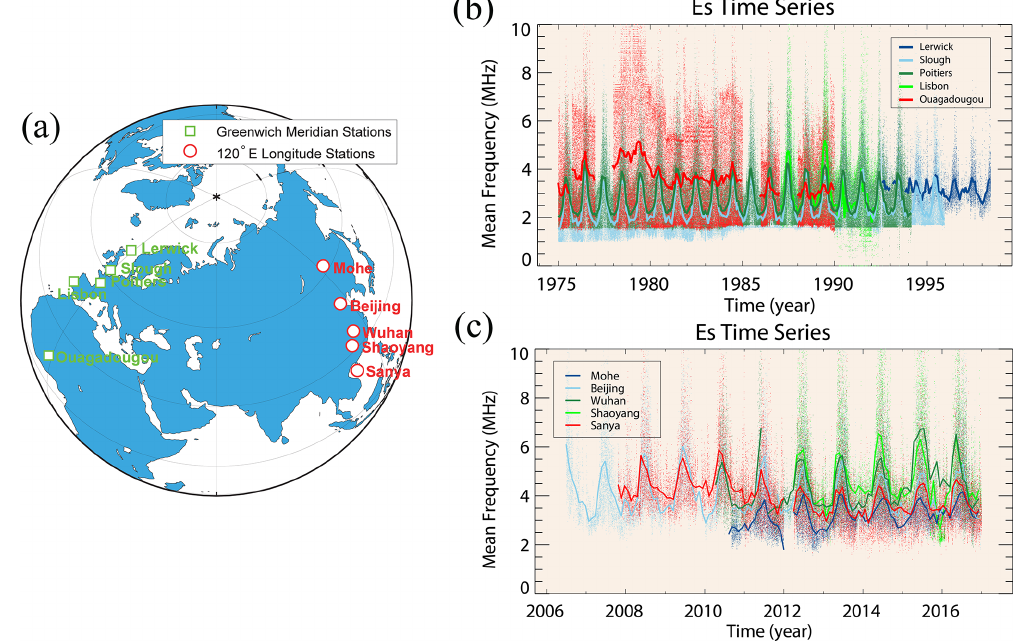
Figure 5. (a) Ground-based measurements of E s from two meridional chains of low-latitude to mid-latitude ionosondes. There are 10 ionosonde stations in these two meridional chains, roughly along the Greenwich meridian (b) and 120 ◦ E (c) . These ionospheric observations started in 1975. A 35-year dataset is analysed to try to identify the signature of the large-scale horizontal transport of metallic ions in E s , induced by meridional